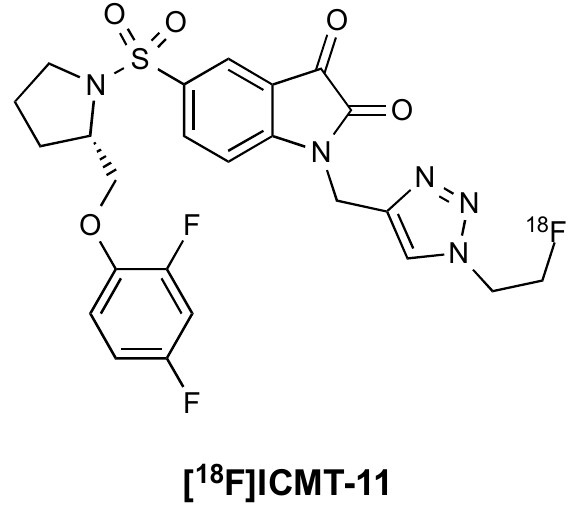
Figure 1. Structure of the caspase ‐ 3 PET radiotracer [ 18 F]ICMT ‐ 11.